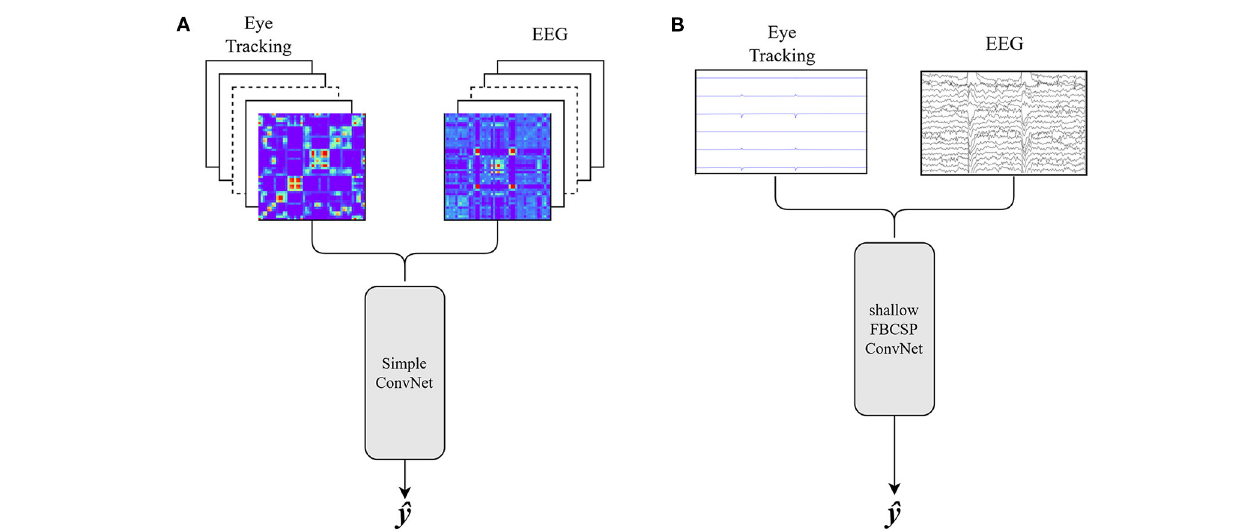
FIGURE 2 | (A) Early fusion approach using image features for EEG and eye tracking data. The stacked images are classified by a Simple Convolutional Neural Network. (B) Early fusion approach using time series of EEG and eye tracking data. The combined input is classified by the shallow FBCSP Convolutional Neural Network. Both: ˆ y is the class prediction.